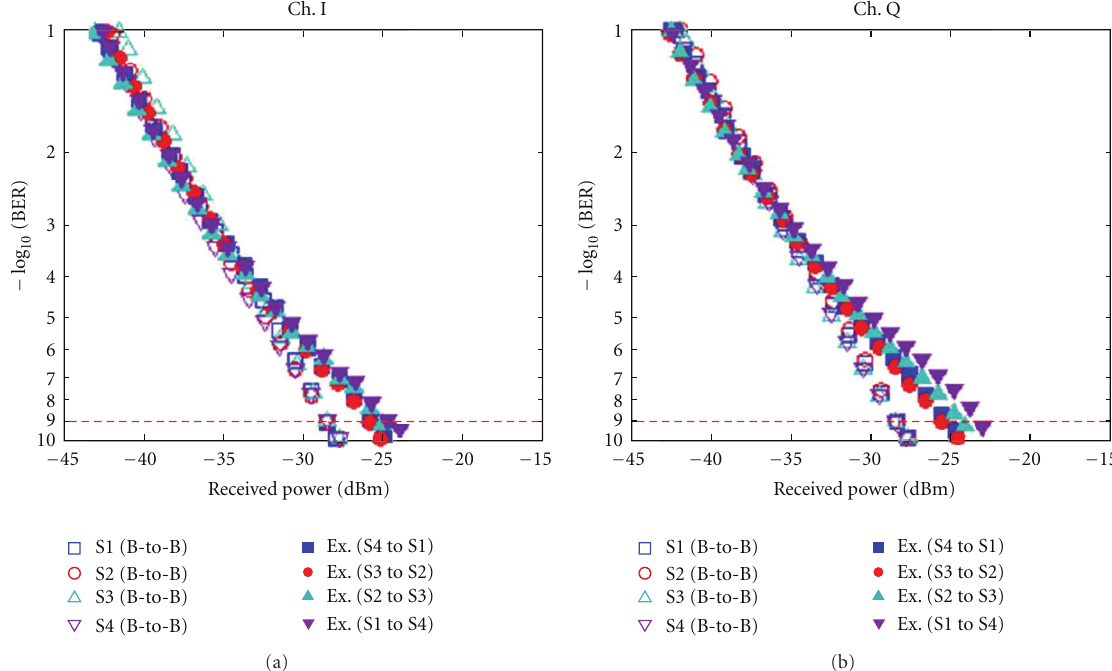
Figure 24: BER curves for simultaneous four-channel 100 Gbit/s DQPSK data exchange.